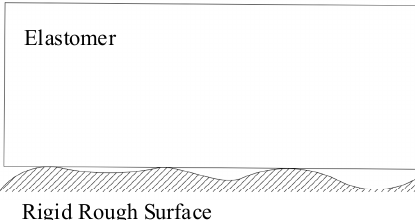
Figure 3. Contact Micrograph.